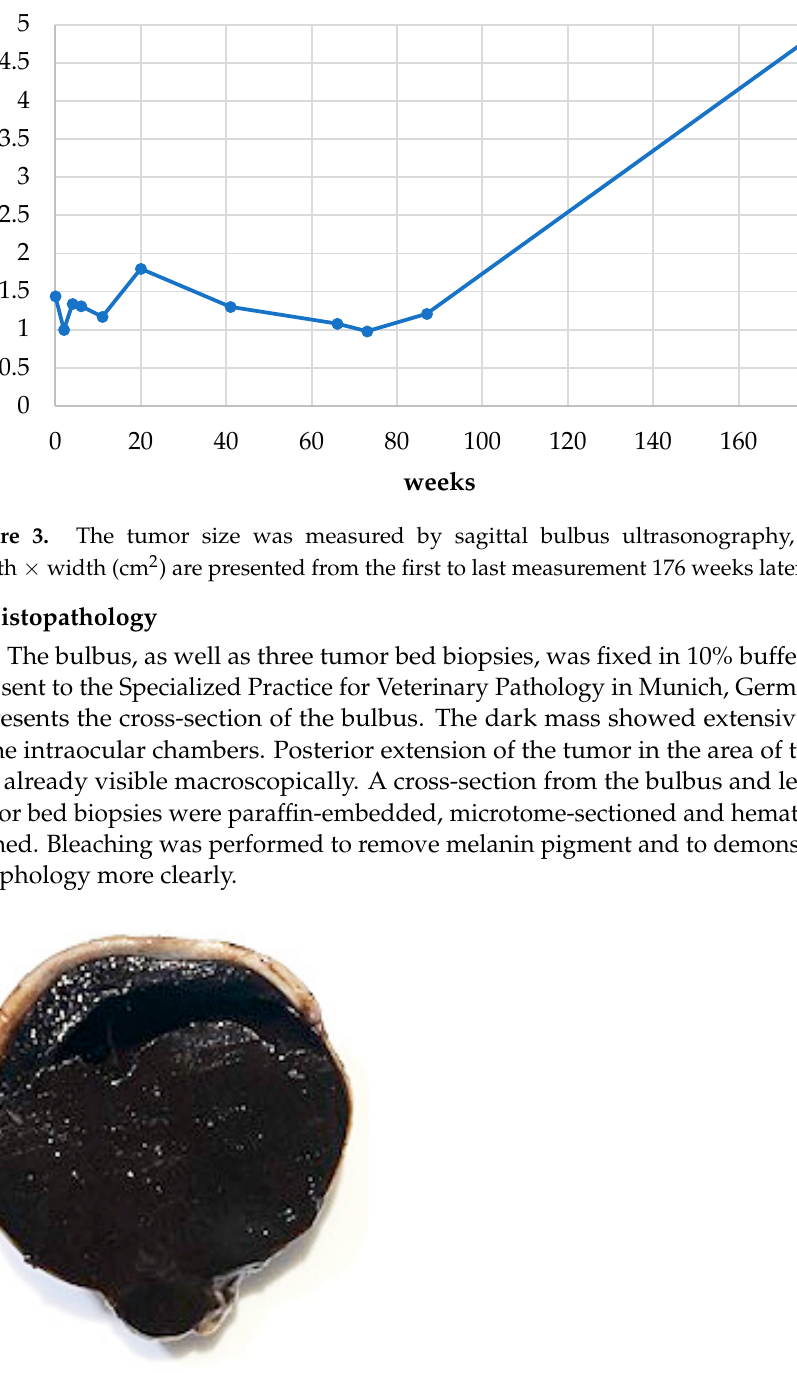
Figure 4. Cross-section of the bulbus. Choroidal melanocytoma with extensive infiltration of the intraocular chambers and posterior extension of the tumor in the area of the optic disc.